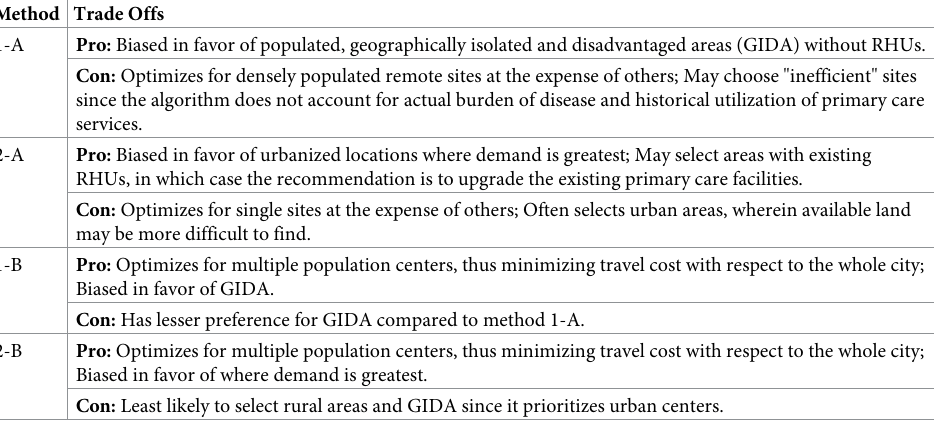
Table 3. Comparison of tradeoffs by